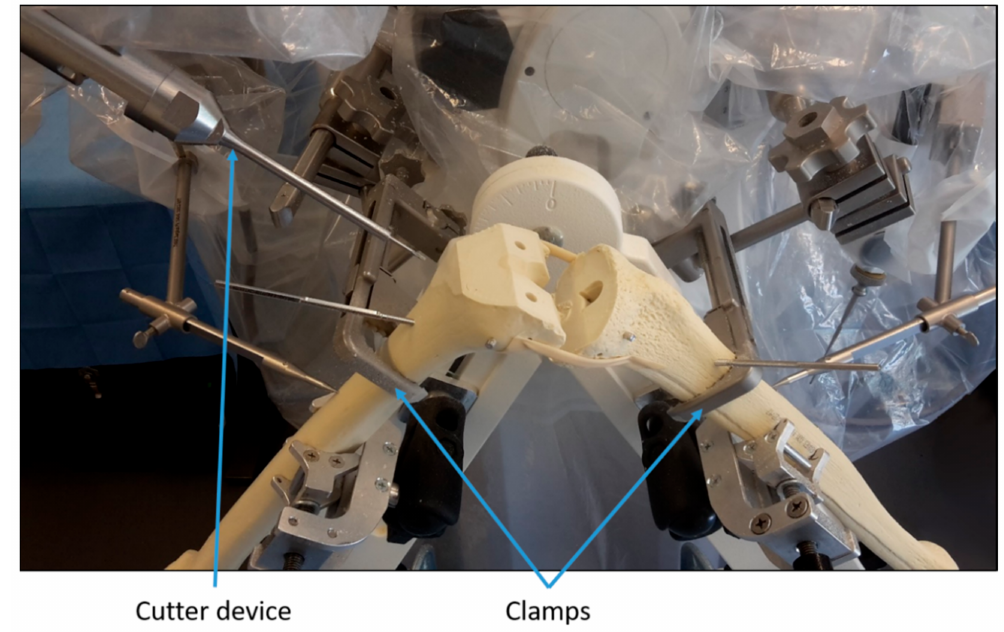
Figure 1. Illustration of the experimental